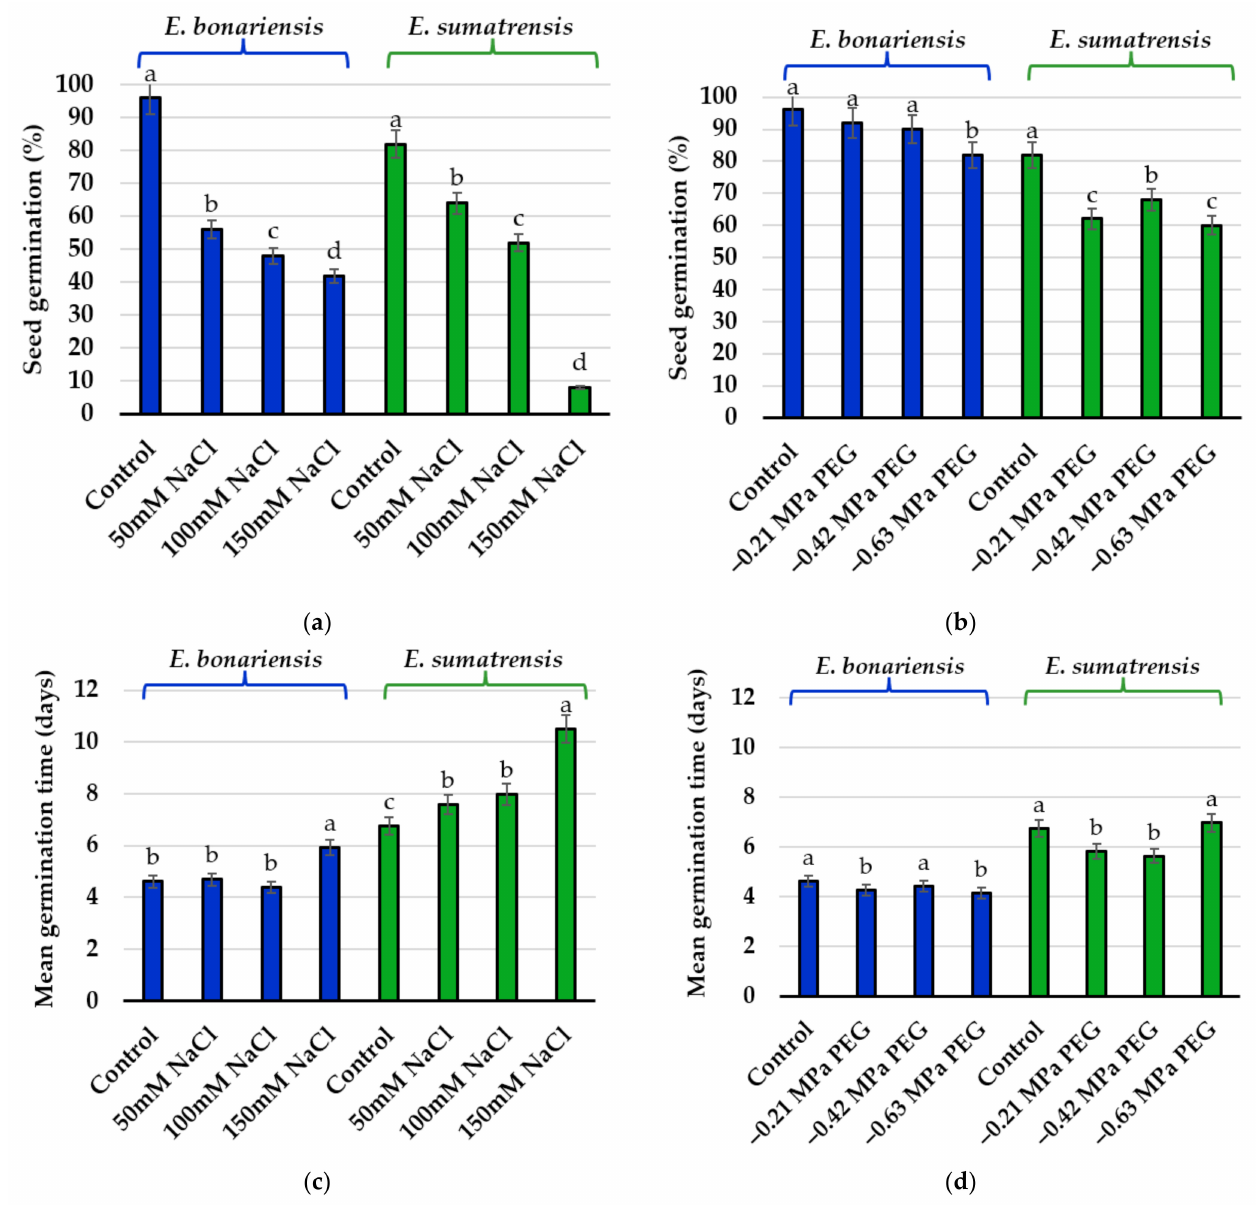
Figure 2. Final germination percentages and mean germination time after 14 days in the presence of increasing concentrations of NaCl and isosmotic concentrations of PEG: ( a ) germination percentage in Erigeron bonariensis and E. sumatrensis under NaCl stress; ( b ) germination percentage in E. bonariensis and E. sumatrensis under isosmotic concentrations of PEG; ( c ) mean germination time in E. bonariensis and E. sumatrensis under NaCl stress; ( d ) mean germination time in E. bonariensis and E. sumatrensis under isosmotic concentrations of PEG. Bars represent mean with SE, n = 5. Different lowercase letters indicate significant differences between treatments, within each species, according to the Tukey test ( α <